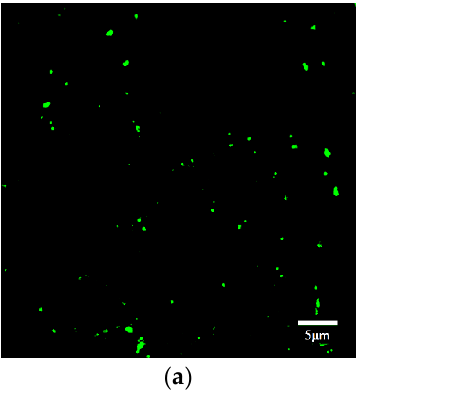
( c ) Figure 1. SEM images of catalyst I and catalyst II . ( a ) General overview of catalyst I ; ( b ) Selected magnification of catalyst I ; ( c ) General overview of catalyst II . The SEM image of catalyst I showed spheres of a regular shape (Figure 1, panel a) with an average diameter of 0.19 ± 0.01 µm, as evaluated by Dinamic Light Scattering (DLS) analysis (Figure 2). Fragmented particles were characterized by the presence of an empty cavity (Figure 1, panel b). The presence of the enzyme in catalyst I was observed by confocal analysis using a tyrosinase previously marked with Fluorescein isothiocyanate (FITC) [54]. As reported in Figure 3 (panel a), catalyst I showed the expected green fluorescence signal inside nanoparticles. The entrapment of tyrosinase was further confirmed by measuring the value of the Zeta potential of the particle surface, which was found to be very similar to the value obtained for the parent OL nanoparticles (Figure 4).